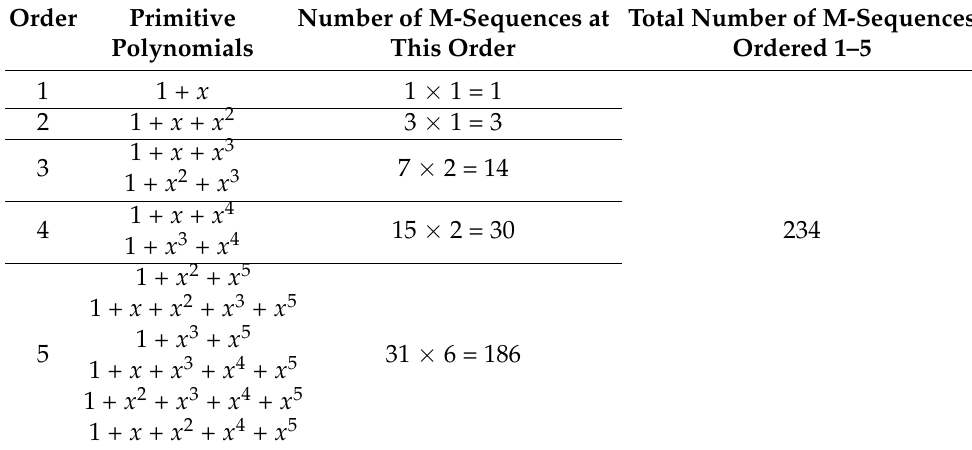
Table 1. Primitive Polynomials and the Numbers of M-Sequences Ordered from 1 to